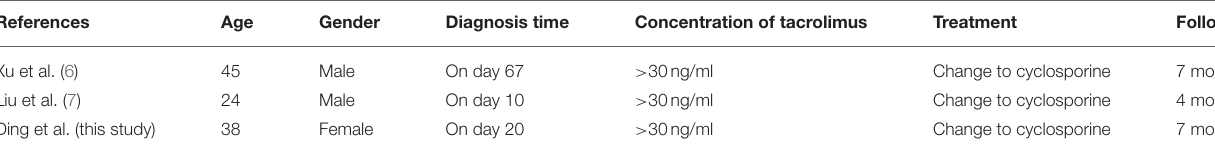
TABLE 1 | Summary of cases of acute pancreatitis due to tacrolimus in kidney